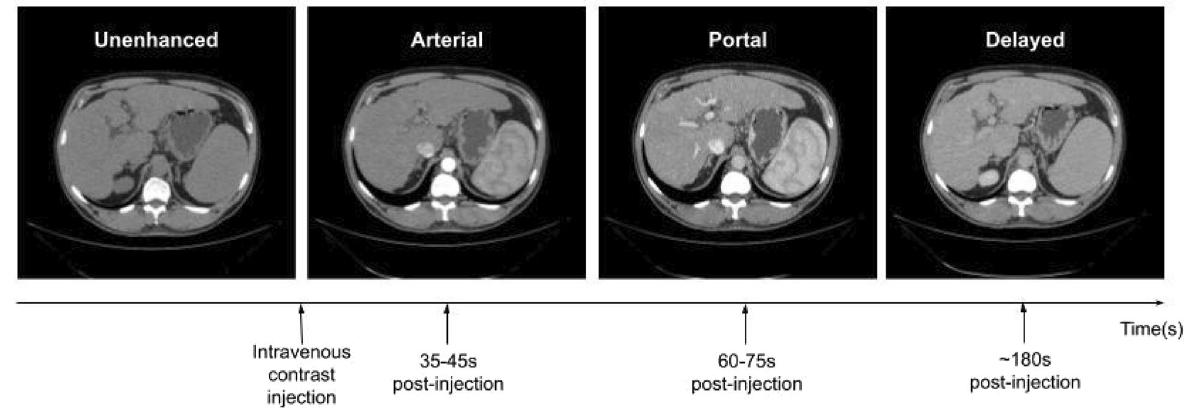
Figure 2. Demonstration of the contrast phases of a liver CT scan.